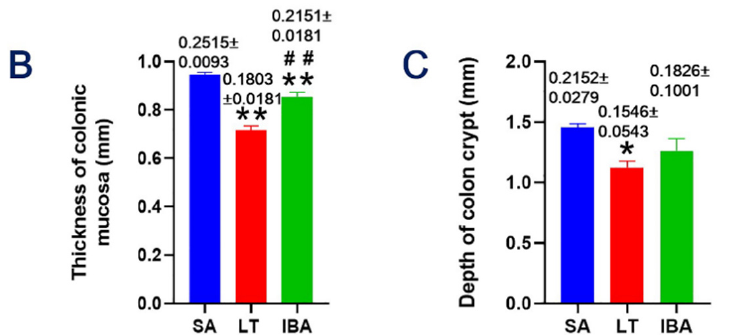
Figure 1. ( A ) HE (hematoxylin–eosin) staining of colonic mucosal tissue of Daurian ground squirrels by light microscope. Columnar epithelial cells (red arrows), goblet cells (GCs) (black arrows), basolateral membrane of subepithelial in surface (gray arrows), basolateral membrane of epithelia in crypt (blue arrows), lamina propria (green arrows). ( B ) Mucosal thickness measured by taking five random fields per section. ( C ) Depth of crypt measured by taking five random fields per section. SA, summer active; LT, late torpor; IBA, interbout arousal. Mean ± SEM. n = 3. * p < 0.05, ** p < 0.01, compared with SA group. ## p < 0.01, compared with LT group.